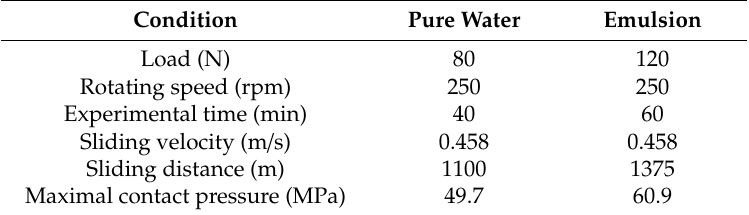
Table 2. Experimental parameters used in block-on-ring friction and wear test